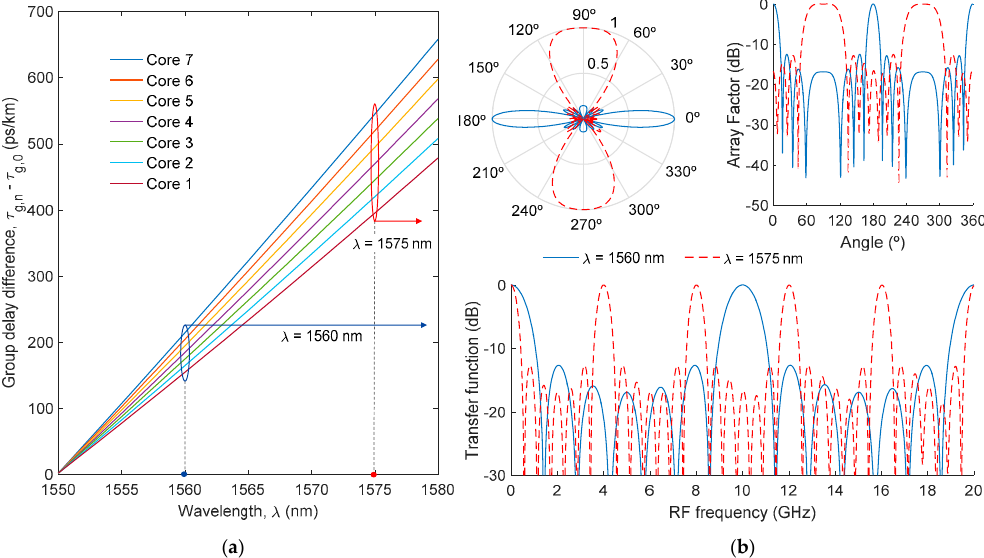
Figure 4. ( a ) Computed group delay of each core as a function of the optical wavelength for the designed multicore fiber; and ( b ) computed array factor as a function of the beam pointing angle (upper part) and computed transfer function as a function of the radio frequency (lower part) for the 10-km link of the designed fiber and an operation wavelength of 1560 nm (blue solid lines) and 1575 nm (red dashed lines).